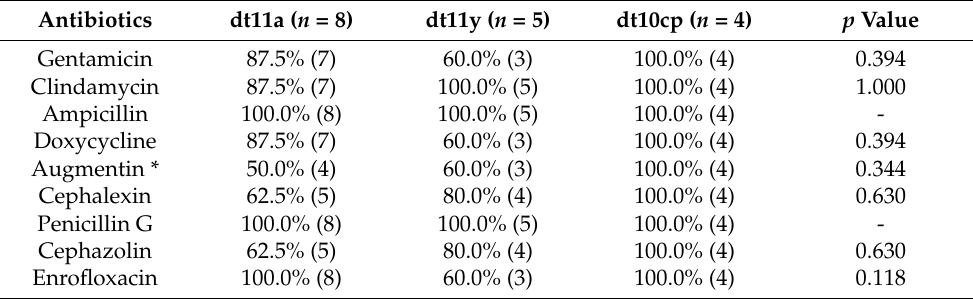
Table 4. Antibiotics resistant profiles and dru gene typing of S. pseudointermedius from